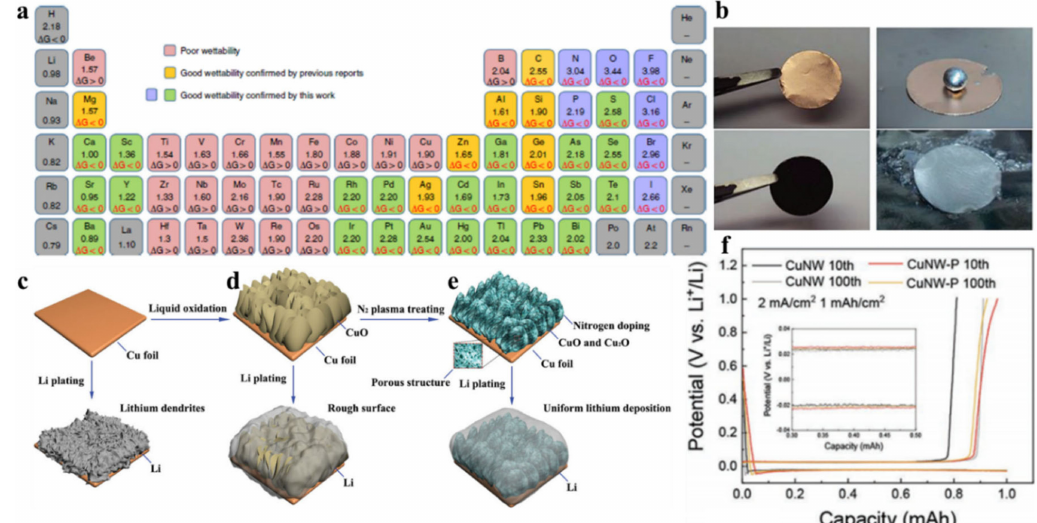
Figure 3. Lithiophilic behavior on the Cu based porous framework. ( a ) Electronegativities of the various elements and ∆ r G of elements / compounds reacted with the molten Li. Reproduced with permission from [50], Springer Nature, 2019. ( b ) Li wettability on the surface of Cu foil and VA-CuO-Cu substrate. Reproduced with permission from [41], John Wiley and Sons, 2018. ( c – e ) Schematic representation of the Li plating mechanism on planar Cu, VA-CuO-Cu, and nitrogen-doped VA-CuO and Cu 2 O-Cu. Reproduced with permission from [39], John Wiley and Sons, 2019. ( f ) Charge / discharge voltage profiles of the CuNW and CuNW-P collectors after 10 and 100 cycles at a current density of 2 mA cm − 2 for a total capacity of 1 mAh cm − 2 of Li. Reproduced with permission from [47], John Wiley and Sons,